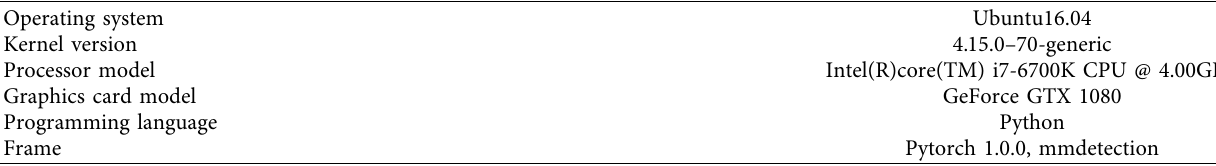
Figure 6: Data augmentation chart. Augmented data ratio: ship, car, big car, airplane, port, storage tank, bridge, swimming pool, tennis court, helicopter, roundabout, baseball field, football field, athletic field, and football field. Table 1: Configuration of experimental environment.